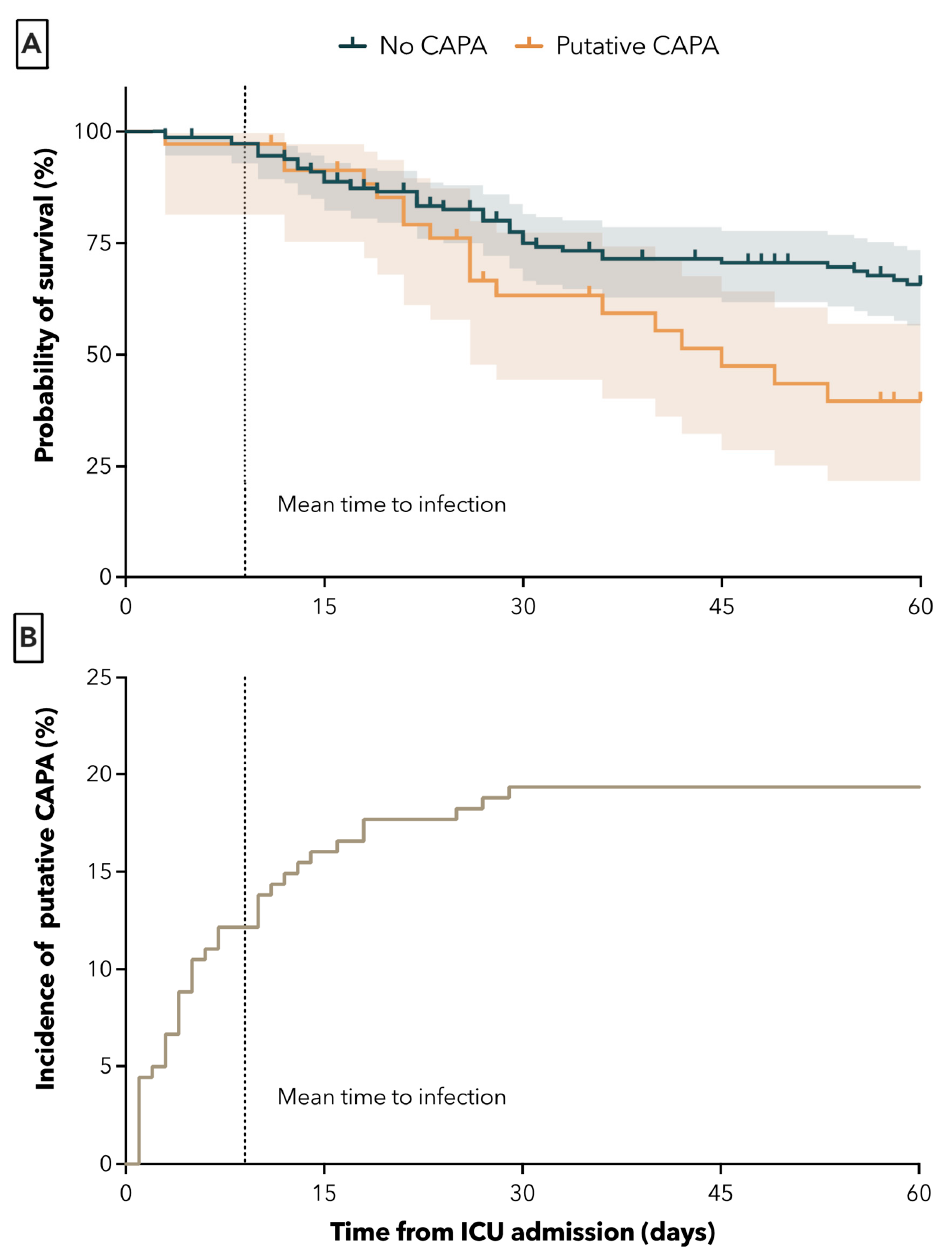
Figure 2. Survival probabilities of patients with and without putative aspergillosis in days after ICU admission ( A ) and mean time to first positive Aspergillus culture from BAL sample ( B ). Dotted lines represent mean time to